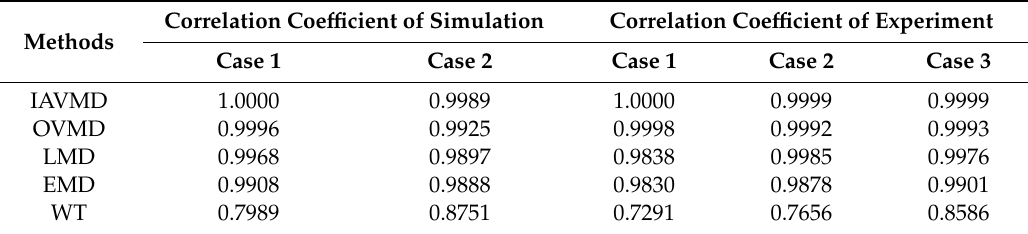
Table 4. The correlation coe ffi cient among di ff erent approaches in the simulation and experiment signal.